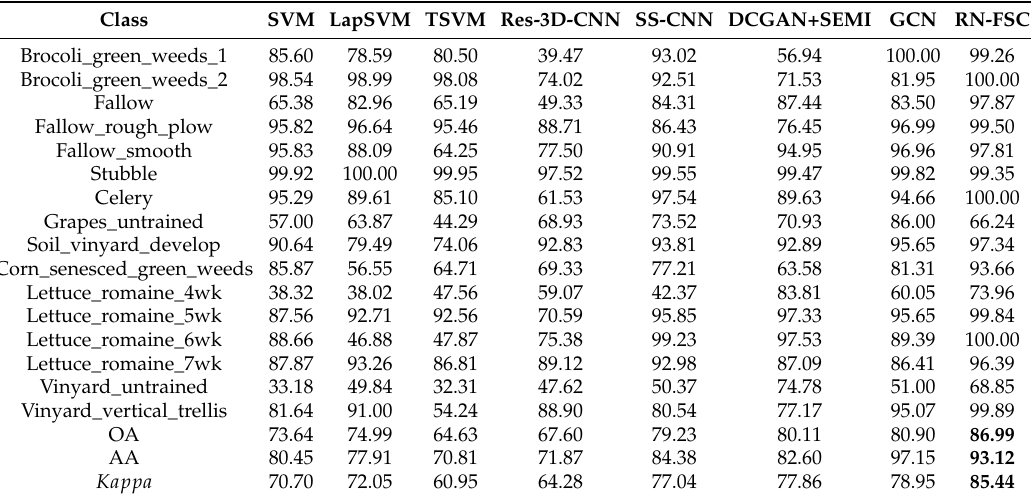
Table 9. Classification results of the different methods on the Salinas data set (5 samples per class in the fine-tuning data set for RN-FSC; 5 samples per class are used for training for other methods; bold values represent the best results among these methods).